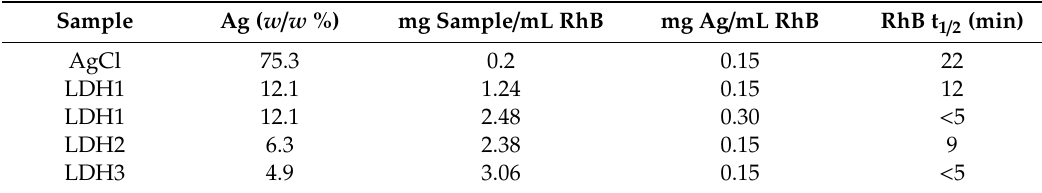
Table 2. Amount of catalyst and silver per mL of RhB 10 − 5 M and estimated half-life (t 1 / 2 ) of RhB.